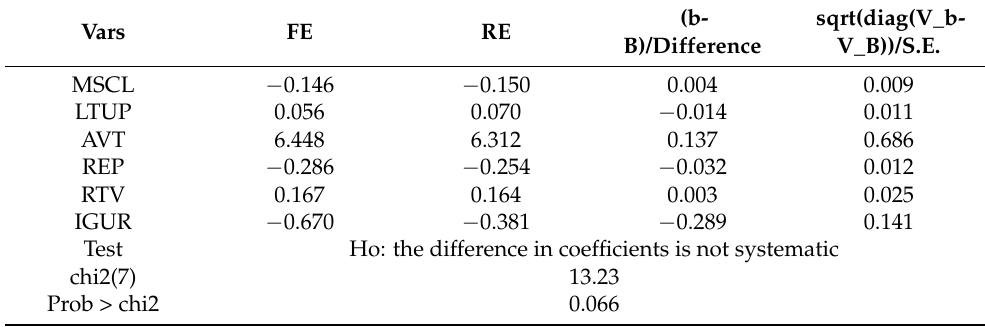
Table A1. Fixed-effect test.